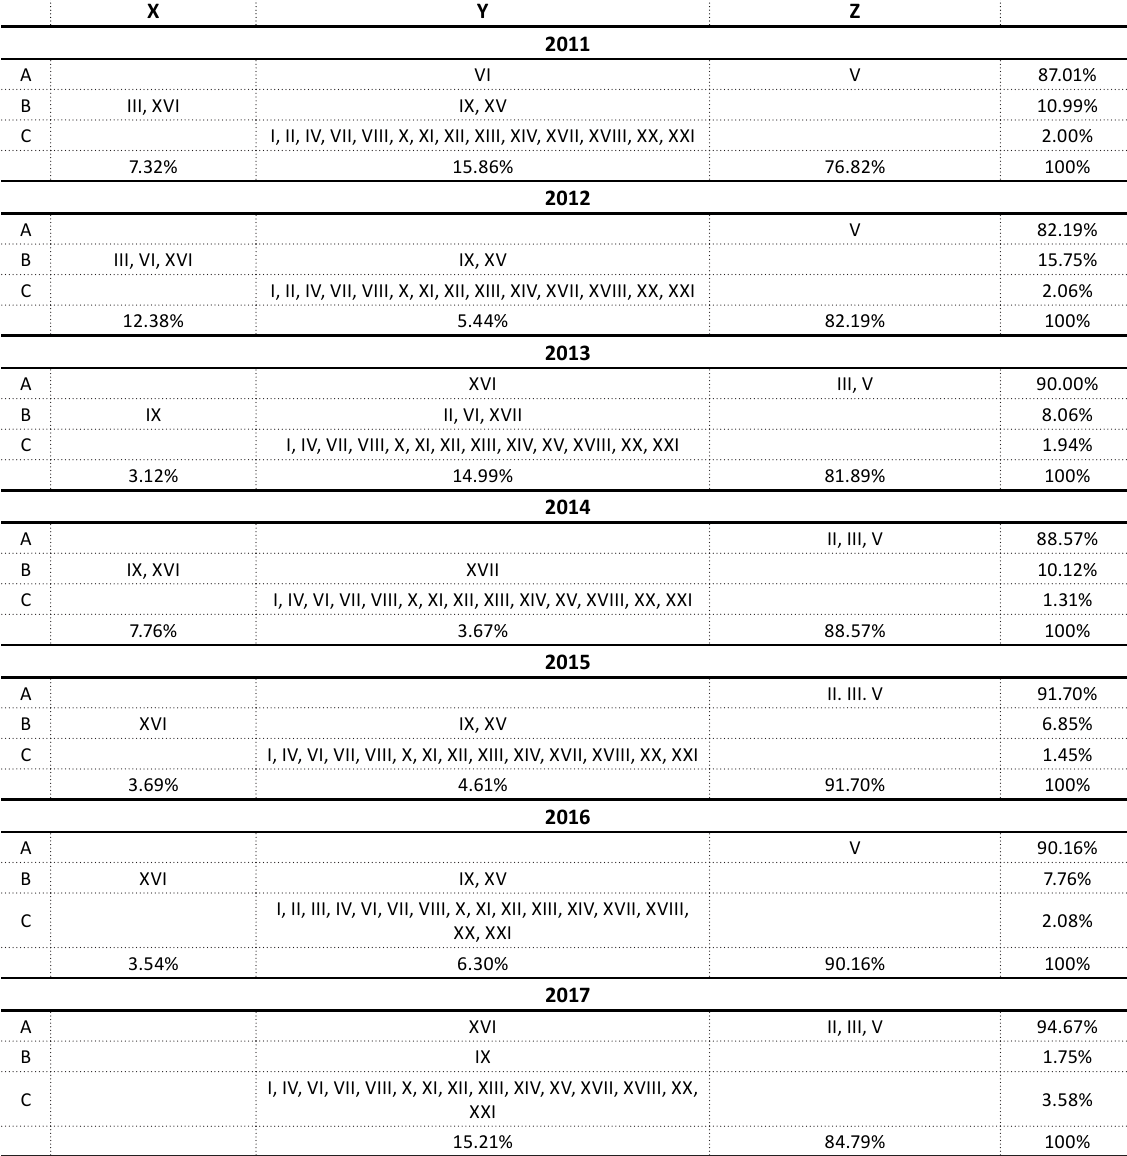
Table 5. Matrix of the structure of Ukraine’s exports to the PRC in 2011–2017 based on ABC, XYZ analysis X